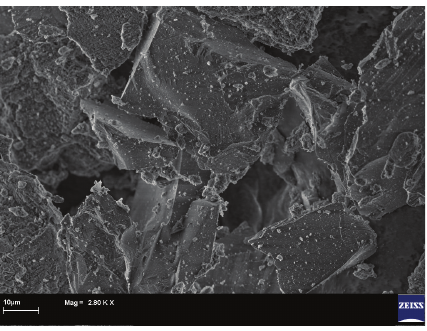
Figure 4: SEM image of 𝛼 -Al 2 O 3